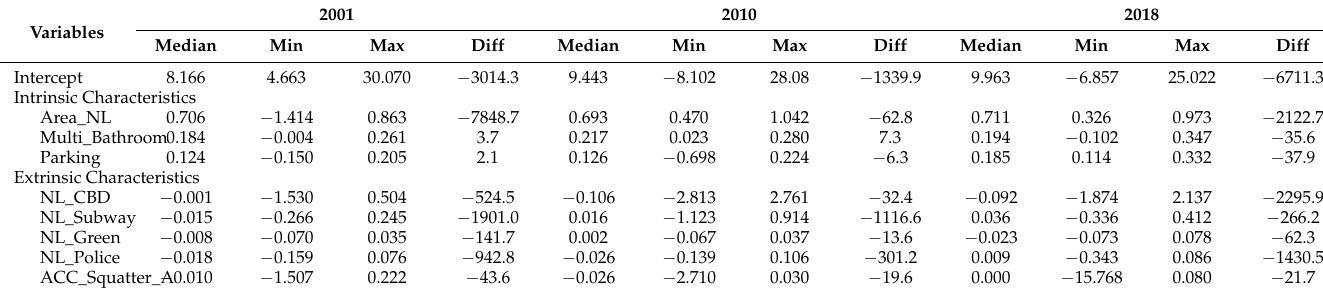
Table 7. Coefficient estimates of the GWR Model